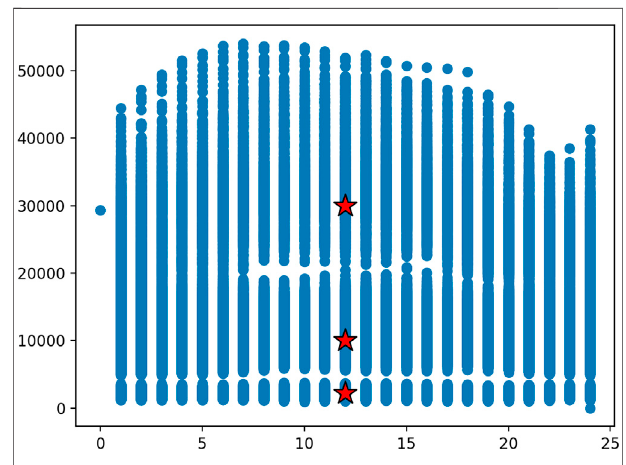
FIGURE 11 | K-means clustering on sample